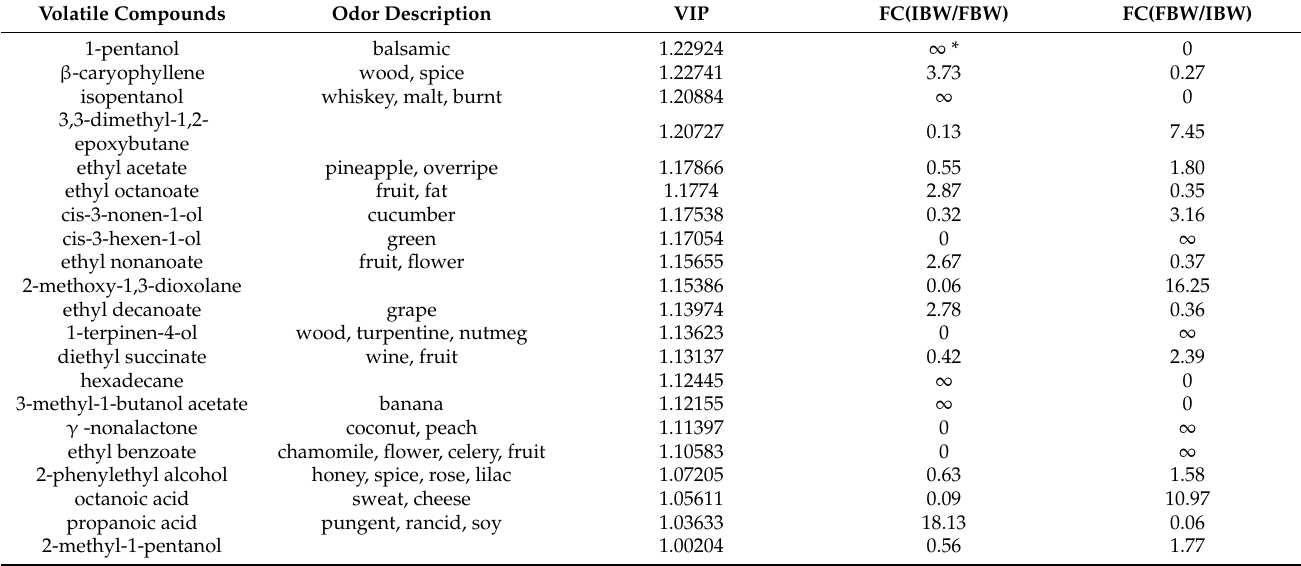
Table 3. Volatile compounds screened out by variable importance in projection (VIP) value of OPLS-DA